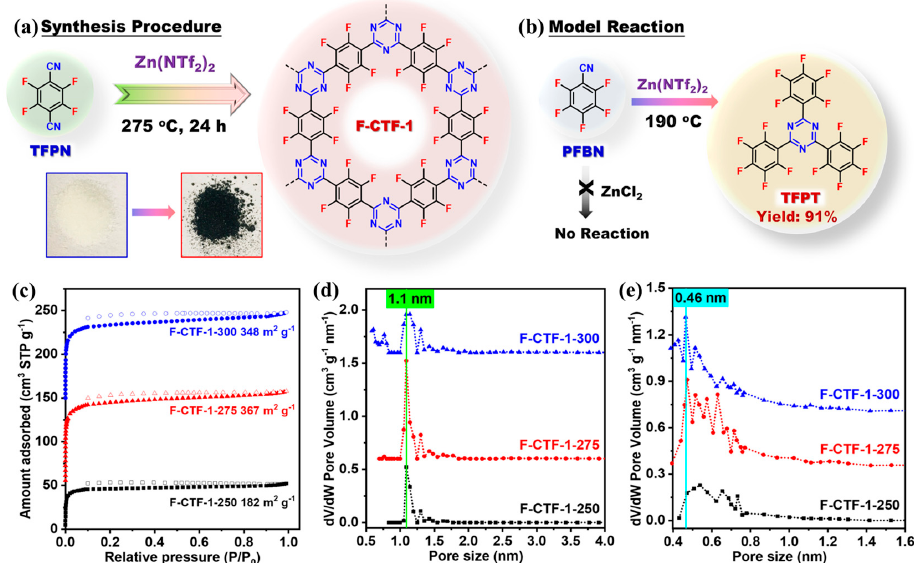
Figure 9. ( a ) Schematic diagram of the synthesis of F-CTF made by ionothermal method under the catalysis of Zn(NTf 2 ) 2 . ( b ) Schematic diagram of the reaction for Zn(NTf 2 ) 2 − catalyzed production of TFPT using PFBN. ( c ) N 2 adsorption/desorption curves of F − CTF − 1 − T; ( d , e ) pore distribution [91]. Reprinted with permission from Ref. [91]. Copyright 2021 Copyright Wiley-VCH (Wehenheim, Germany).